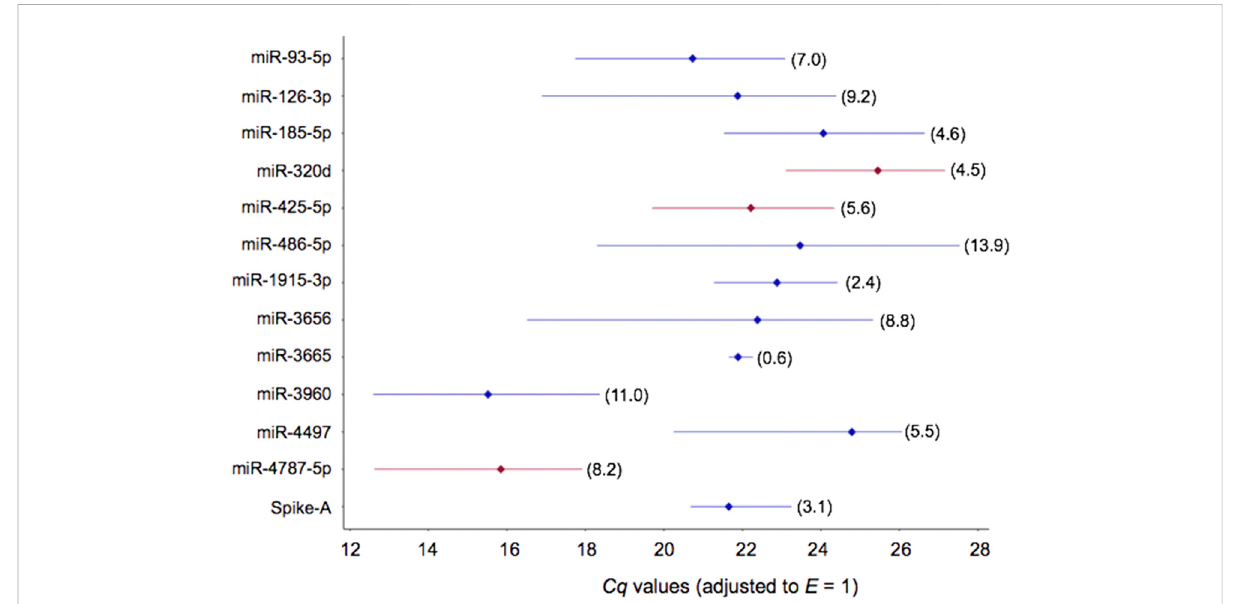
FIGURE 3 Pro fi lesof Cq valuesof13candidatereferencemiRNAsacross32bloodplasmasderivedfromprobandswithdifferentmodesofcognitivestress coping. Cq values were corrected with the ampli fi cation ef fi ciency value determined for the respective qPCR assay (Table 2). The median value is depicted by the diamond. The percent coef fi cient of variation ( CV ) is given in parentheses. miRNAs composing the two-gene NF s either recommended for plasma or the two stress-coping dimensions are highlighted in